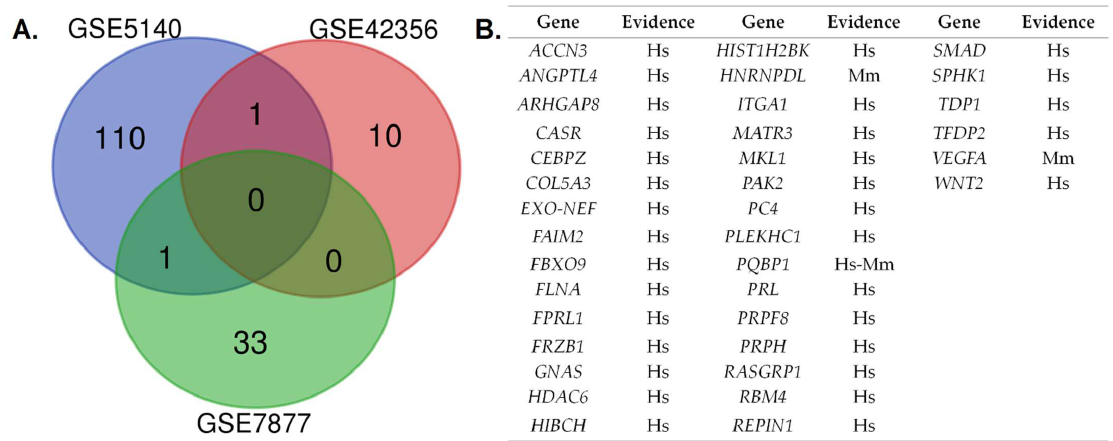
Figure 2. Convergent analysis of the differentially expressed genes obtained from the three datasets: ( A ) Venn diagram comparing differentially expressed genes identified in the included datasets (adjusted p < 0.05); ( B ) list of genes derived from the convergent functional genomics analysis in human and mouse models. Hs: Homo sapiens ; Mm: Mus musculus .